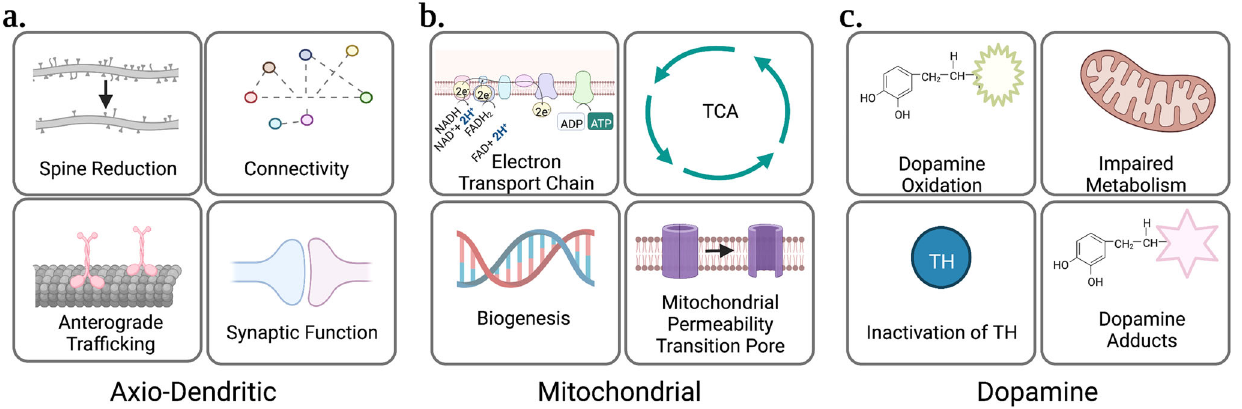
Fig. 3 RNS-induced dysfunctions in Parkinson ’ s disease. This schematic highlights the major phenotypes that arise as a consequence of RNS in PD. This includes axo-dendritic defects ( a ), mitochondrial defects ( b ) and dopamine-induced defects ( c ) discussed in this review. This fi gure was created using